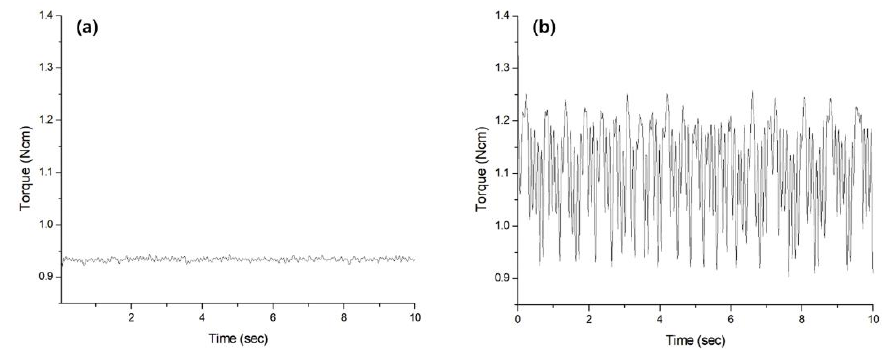
Figure 3. Different torque generation patterns between ( a ) continuous rotary (ProTaper Next; Dentsply) and ( b ) reciprocation movement (WaveOne; Dentsply) in the artificial root canal with 15° angle of curvature [13].